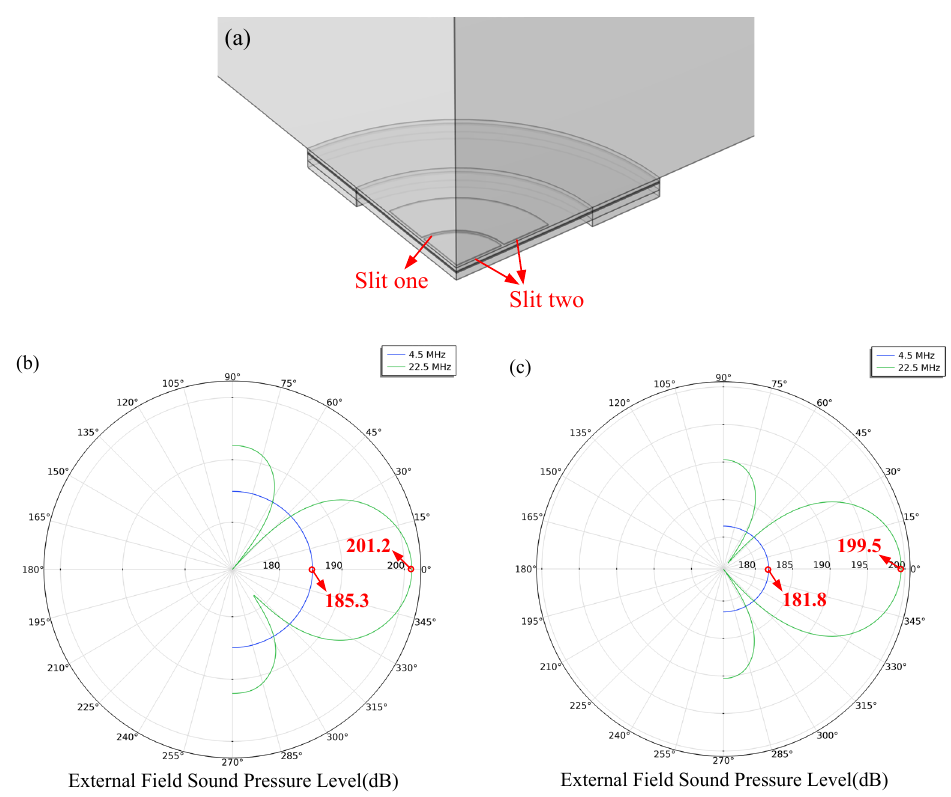
Figure 6. ( a ) One-quarter of the modified unit model; ( b ) radiation pattern of the clamped structure; ( c ) radiation pattern of the double-slit structure.